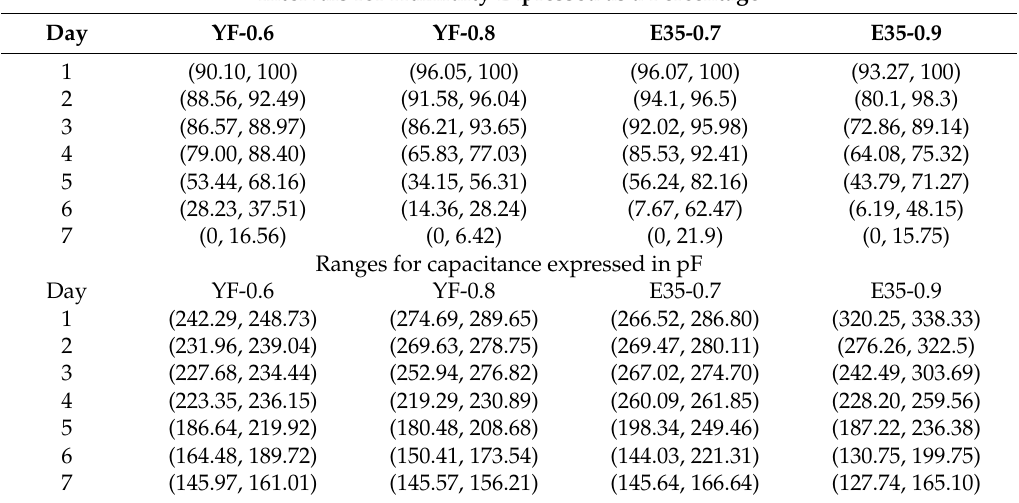
Table 4. Confidence intervals for moisture, capacitance, flexural strength, and compressive strength measured daily on each